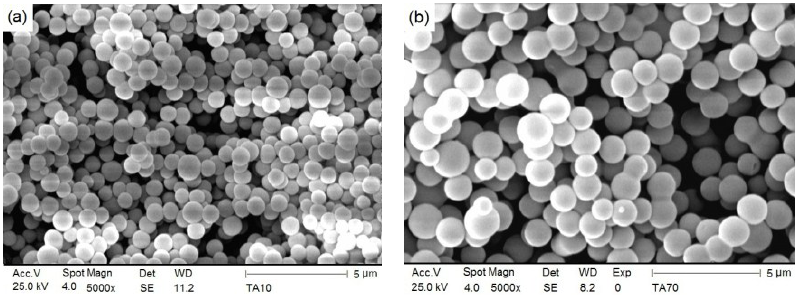
Figure 9. Synthesized particles in presence of different TEOS molar ratios: a) 0.9, b)